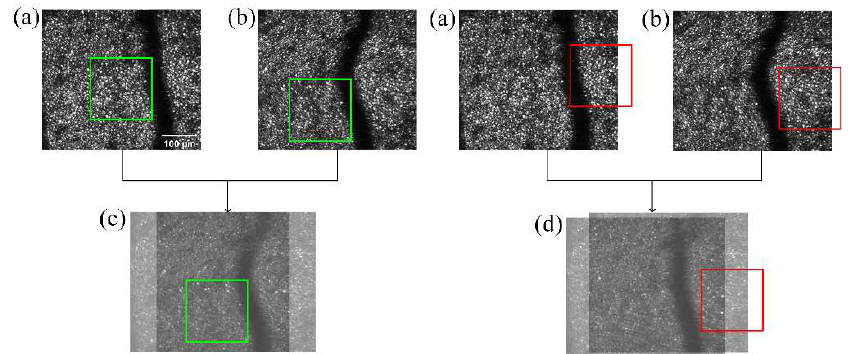
Figure 7. The frame with the largest vertical displacement difference; ( a ) is the first frame of the sequence; ( b ) shows the frame with the largest difference between UECO and manual registration; ( c ) is the result of UECO; and ( d ) is the result of manual registration. The green and red boxes are the references for the UECO and manual registration, respectively. For display purposes, the transparency in ( c , d ) was set to 50%. The scale bar is 100 µm.